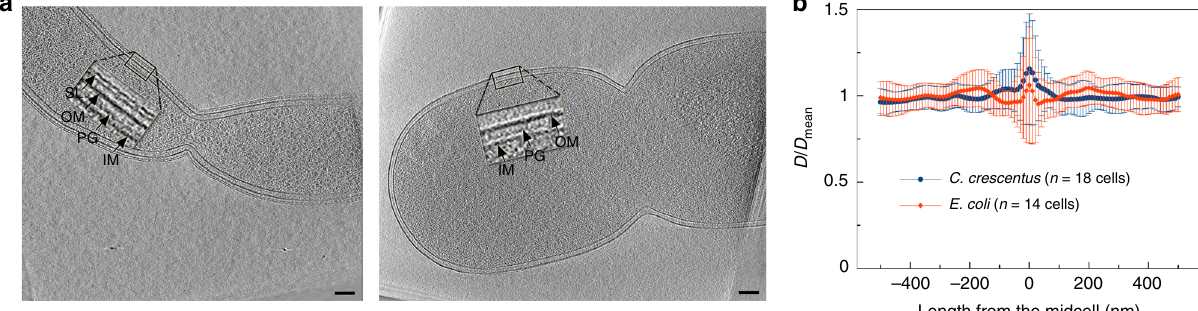
Fig. 7 Electron cryotomography of dividing Gram-negative bacterial cells. a Representative tomographic slices through dividing Caulobacter crescentus (left) and Escherichia coli cells (right). Arrows point to the S-layer (SL), outer membrane (OM), peptidoglycan (PG), and inner membrane (IM). Scale bars indicate 100 nm. b Calculation of the distance D between the two membranes shows that it is maintained throughout the invagination site at the midcell. Error bars indicate standard